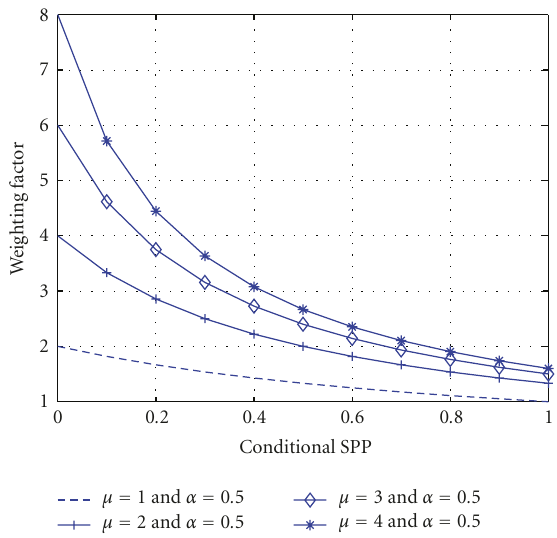
Figure 9: Speech presence probability-based weighting factor with a lower threshold.